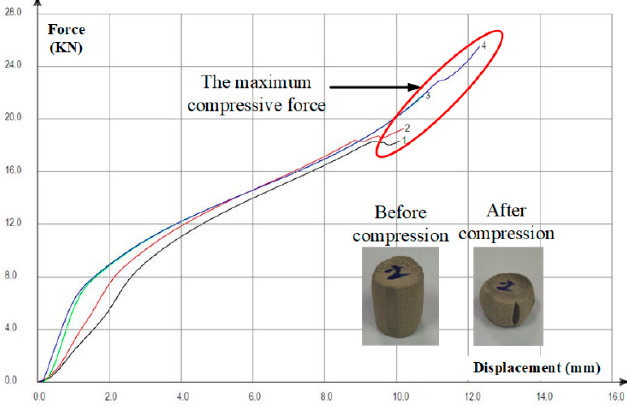
Figure 3. Variation curve of compressive force of SiC/PA12 composites.